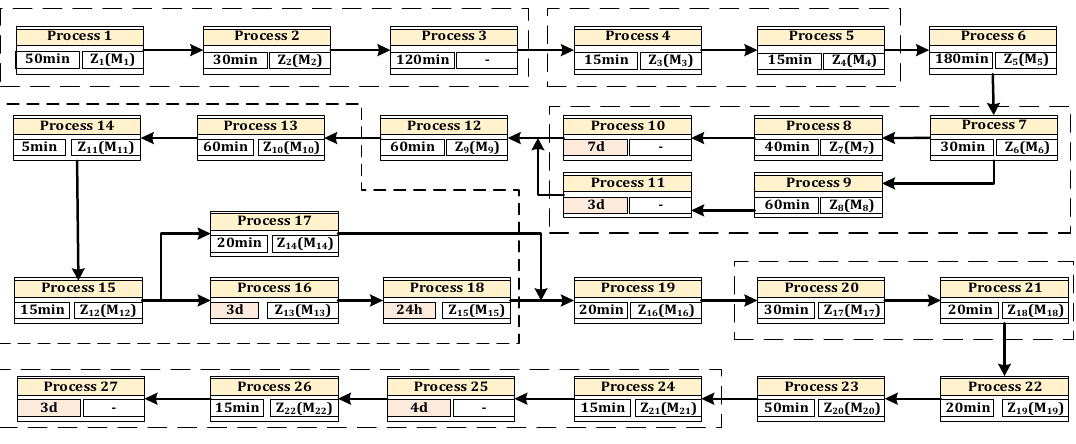
Figure 1. The assembly process of case product.